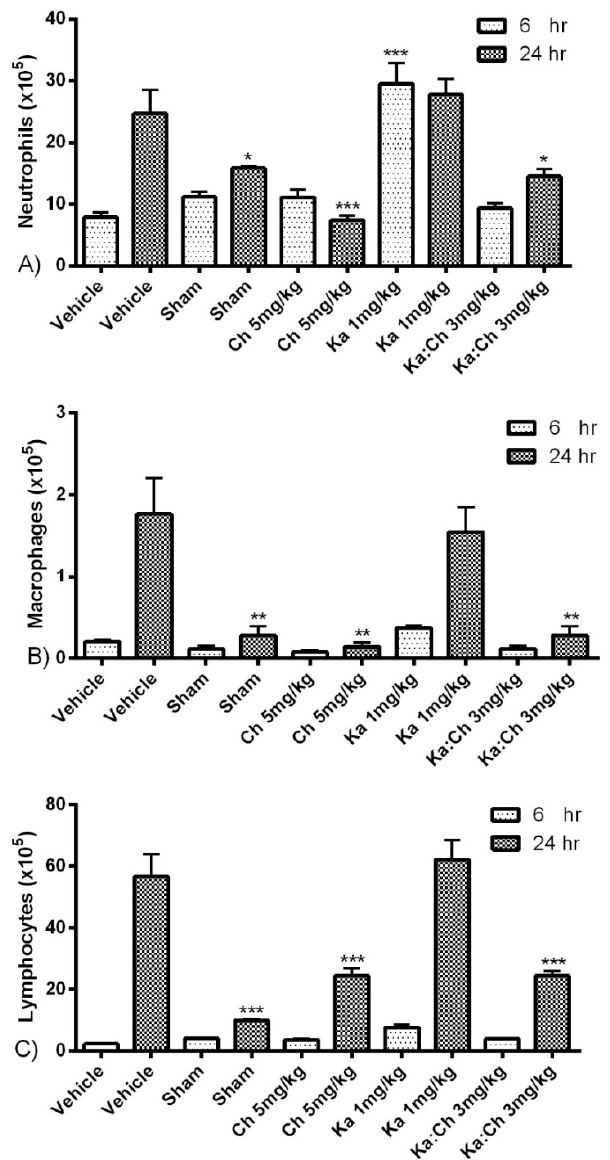
Figure 5. The effects of kaempferol and chrysin individual and combination treatments on IPF differential leukocytic count 6 and 24 h after CLP; ( A ) neutrophils; ( B ) macrophages; and ( C ) lymphocyte. Cells of lavaged IPF were fixed on slides through cytospin and then Wright’s stained for differential leukocytic count. Data represent actual cell numbers. * p ≤ 0.05, ** p ≤ 0.01, and *** p ≤ 0.001 versus CLP/vehicle of the same time point (Student’s t